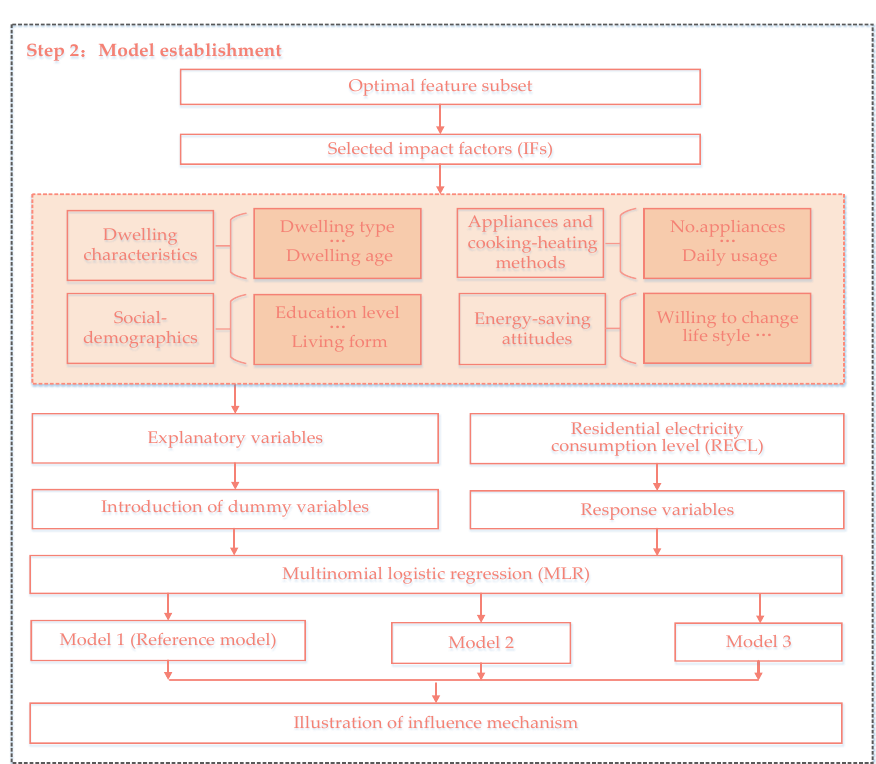
Figure 3. The detailed framework of step 2.